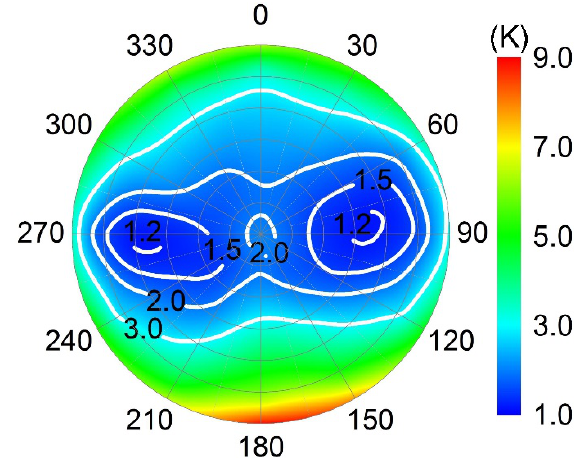
Fig.4 The polar-| ∆ T | mean of average absolute difference between T c and T ( θ , φ ) (the sun azimuth is unified and rotated to the south).